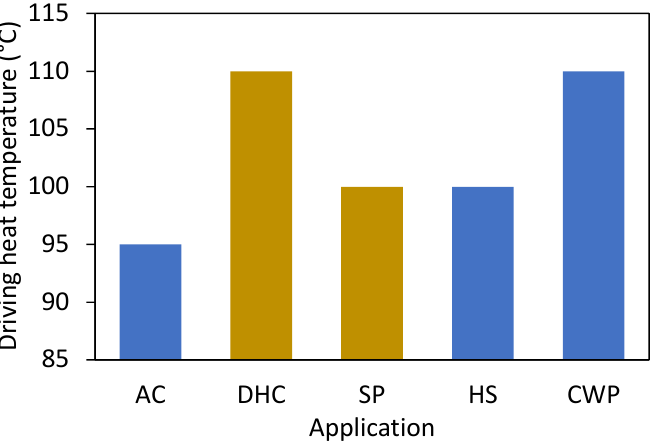
Figure 11. Driving heat temperature required for each application. Note: AC = air conditioning; DHC = 4th Generation District Heating and Cooling Network; SP = sports center with an indoor swimming pool; HS = hybrid air conditioning system; CWP = cooling and water purification.